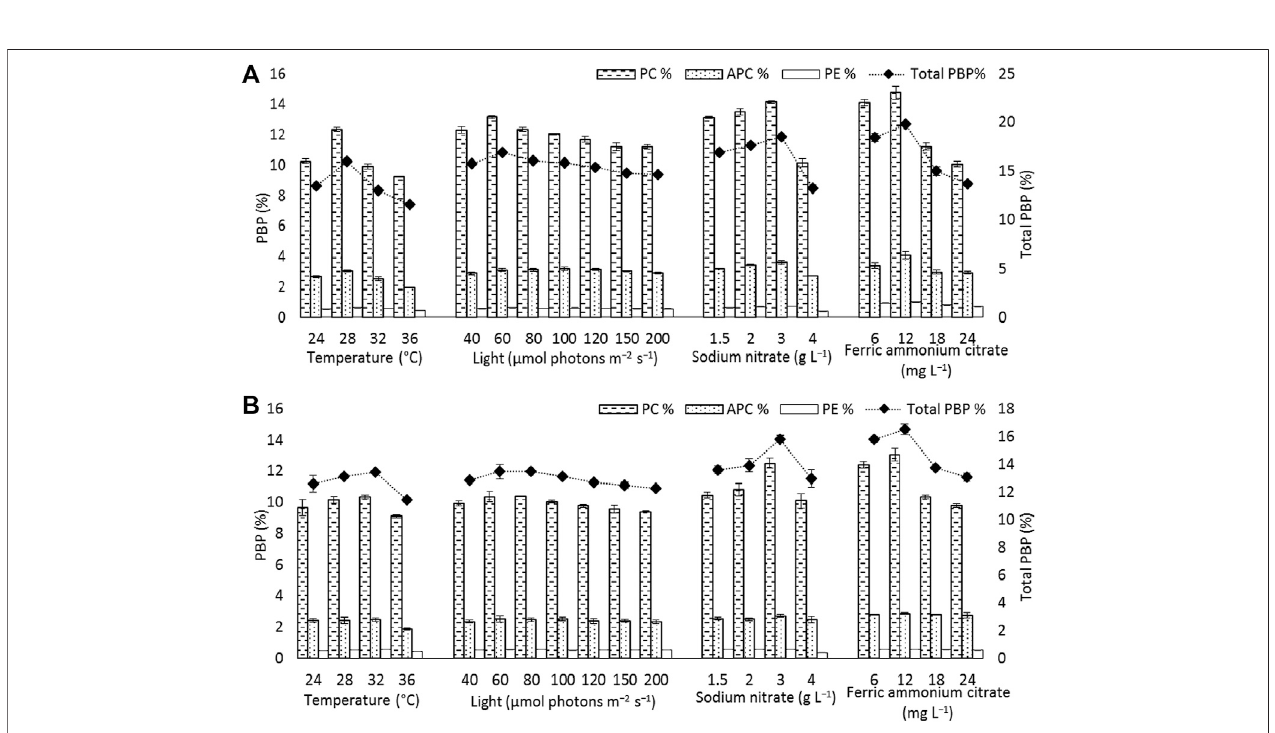
FIGURE 5 | Phycobiliprotein content [phycocyanin (PC), allophycocyanin (APC), and phycoerythrin (PE)] and total phycobiliprotein (PBP) content of (A) Euryhalinema sp. (B) Deserti fi lum sp. grown under different temperature, light, and nutrient conditions (sodium nitrate and ferric ammonium citrate) at late exponential phase (12th day cultures). Error bars represent ± SD (n (cid:2) 3).